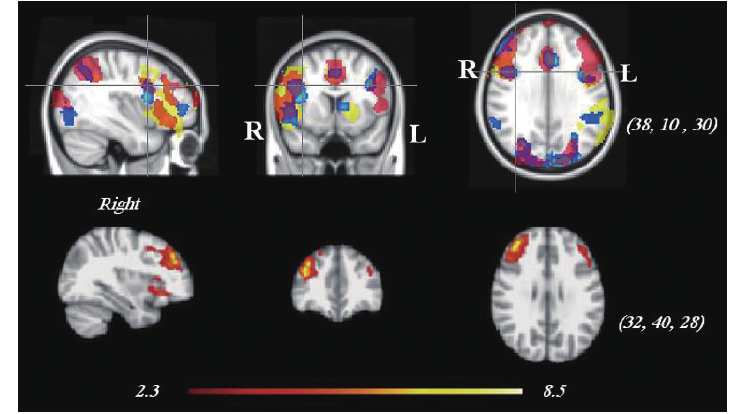
Fig. 2. Top: Group activation map for the visual (red), verbal (blue) and auditory (yellow) working memory in all subjects (both groups). Bottom: Combined task analysis that shows frontal regions as shared activation across the tasks. Numbers in parentheses indicate “x”,” y” and “z” levels on sagittal, coronal, and axial